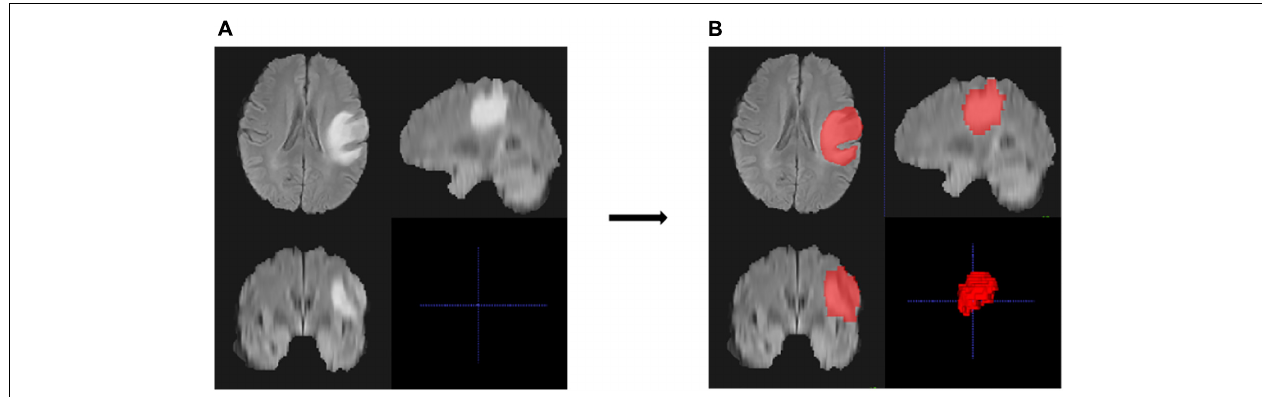
FIGURE 2 | An example of region of interest (ROI) and the segmentation results of the MRI images of one patient. (A,B) Cross-section views of images before segmentation (A) and after manual segmentation (B) . The lesion in the original image was high and showed a bright signal (A) , and the ROI of the lesion area is represented as red after segmentation (B)